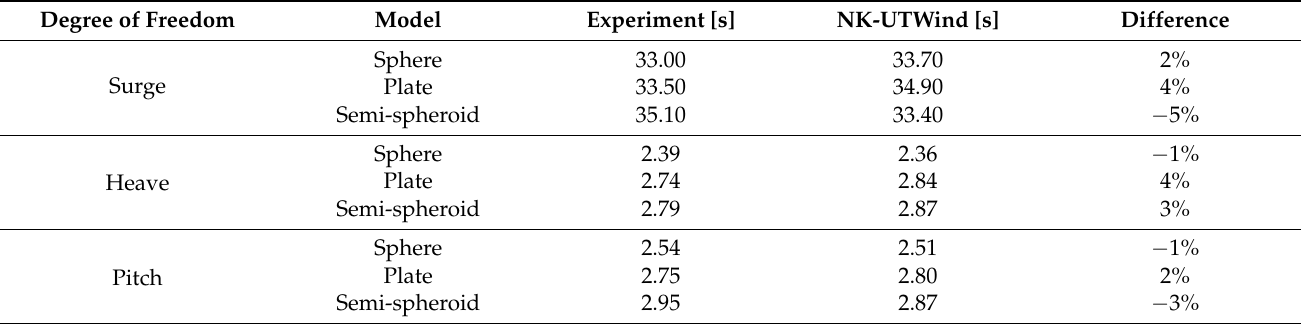
Table 4. Natural periods, T n , were obtained from free decay tests in still